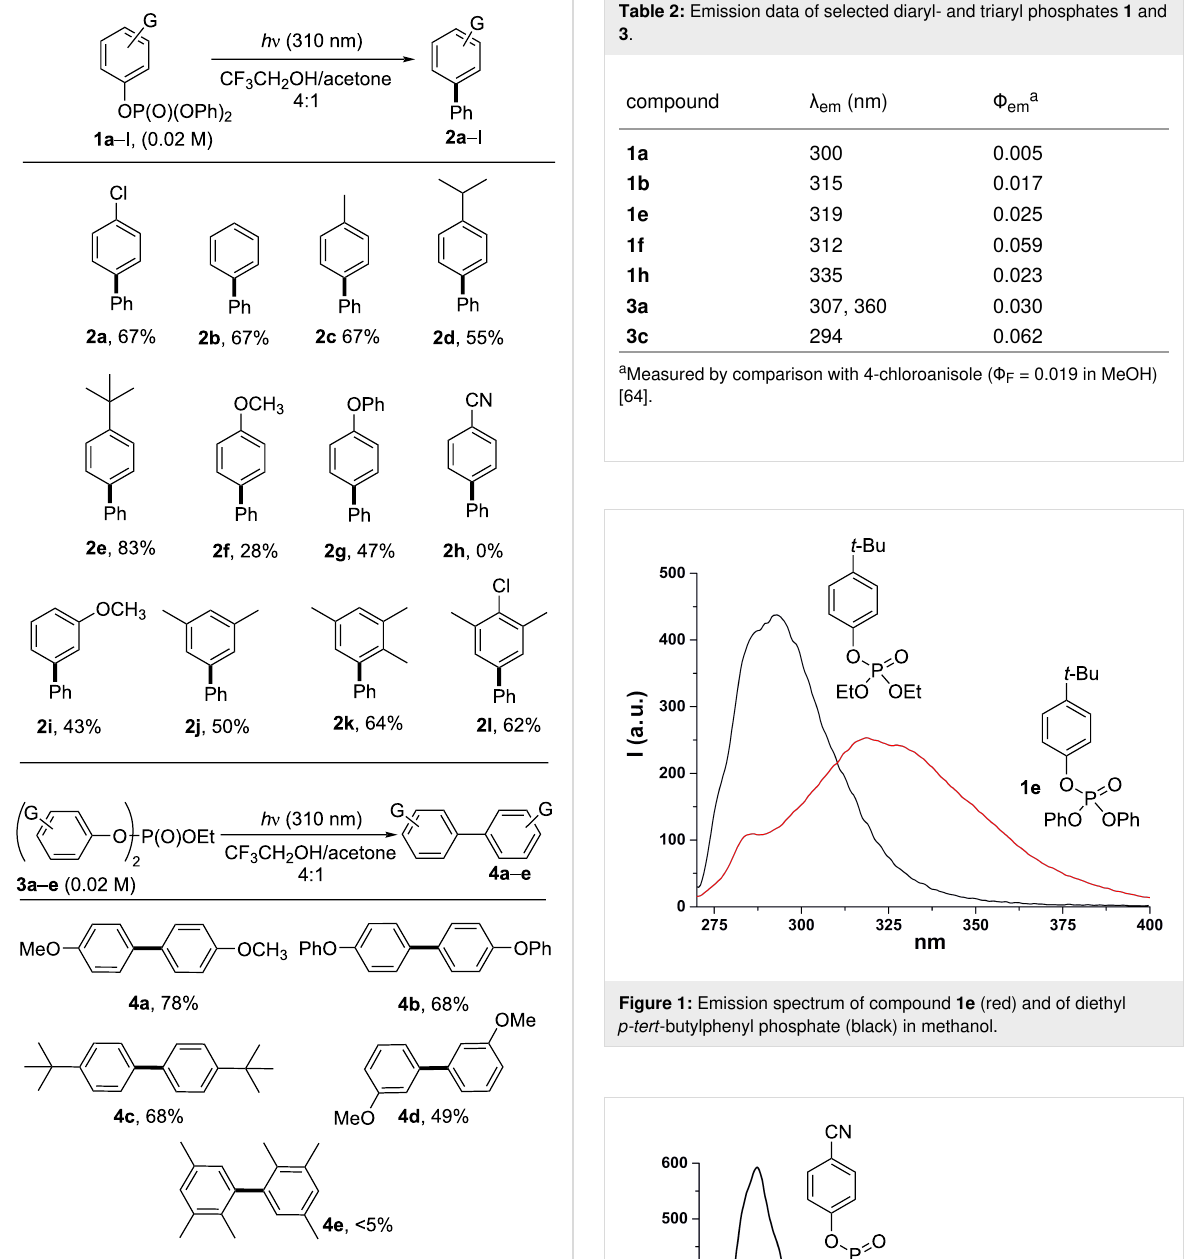
Scheme 2: Metal-free photochemical synthesis of biaryls 2 and 4 .